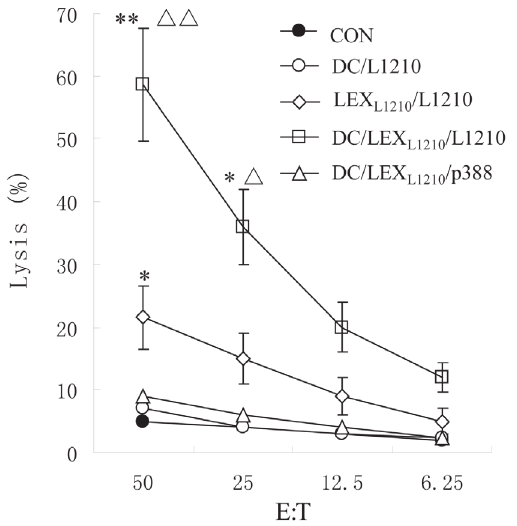
Figure 3. Cytotoxicity assay. Cytotoxic responses were evaluated by the lactate dehydrogenase (LDH)-releasing method. Splenic T-cells from mice immunized intravenously with L1210-derived exosomes (LEX L1210 ) and dendritic cells (DCs) pulsed with LEX L1210 or phosphate-buffered saline (PBS) as a control were harvested and co- cultured with irradiated L1210 cells. At the end of the culture period, viable T-cells were separated using Ficoll-Paque centrifugation and were thereafter referred to as effector cells. The LDH assay is an enzymatic method used to colorimetrically quantify LDH released from lysed target cells, including L1210 or P388 cells, which served as the control and were mixed at different ratios with effector cells after incubation for 4 h at 37 u C. The spontaneous/maximal release ratio was , 20% in all experiments. Specific lysis (%) was calculated as follows: (experimental LDH release – effector cell spontaneous LDH release – target spontaneous LDH release)/(target maximum LDH release) 6 100. * P , 0.05 compared with the PBS, DC, and P388 groups; ** P , 0.01 compared with the PBS control group; g P , 0.05 compared with the LEX L1210 group; gg P , 0.01 compared with the LEX L1210 group. Experiments were performed in triplicate. One representative experi- ment is shown.